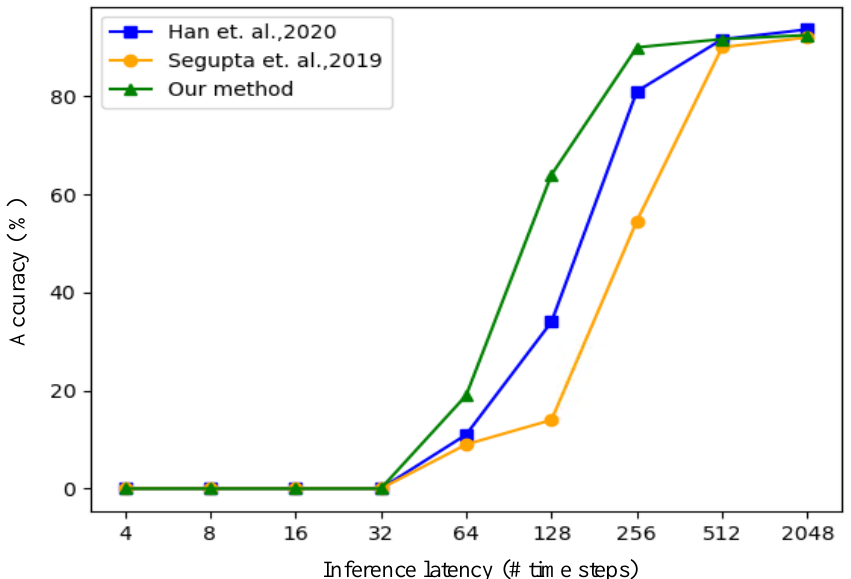
Figure 11. Performance comparison of the proposed method and other CNN–SNN conversion methods on the CIFAR-10 dataset